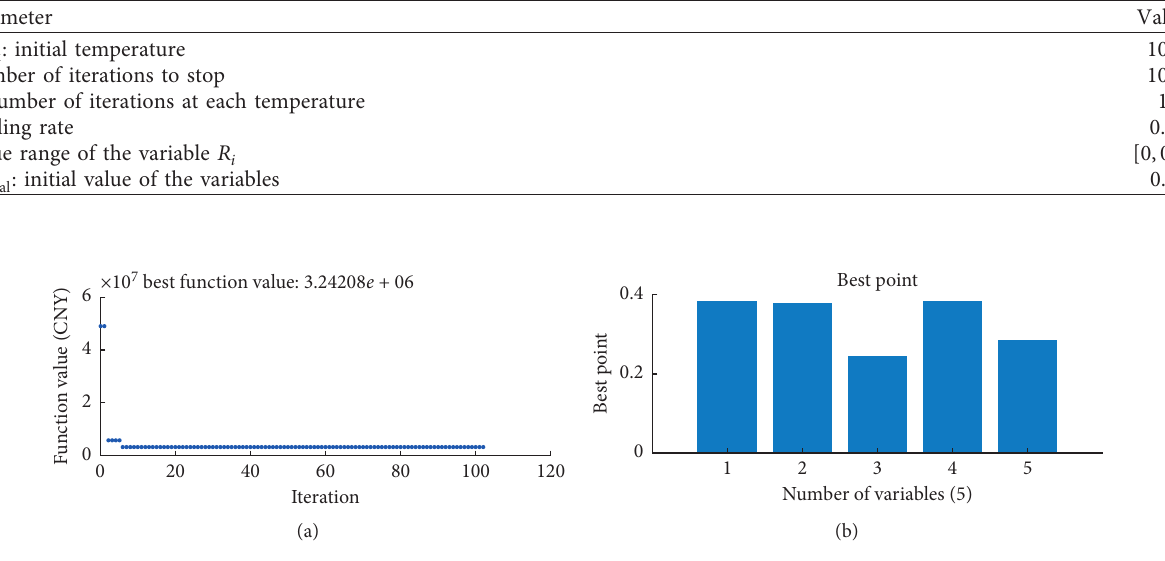
Figure 10: The convergence of SA algorithm for the maintenance cost